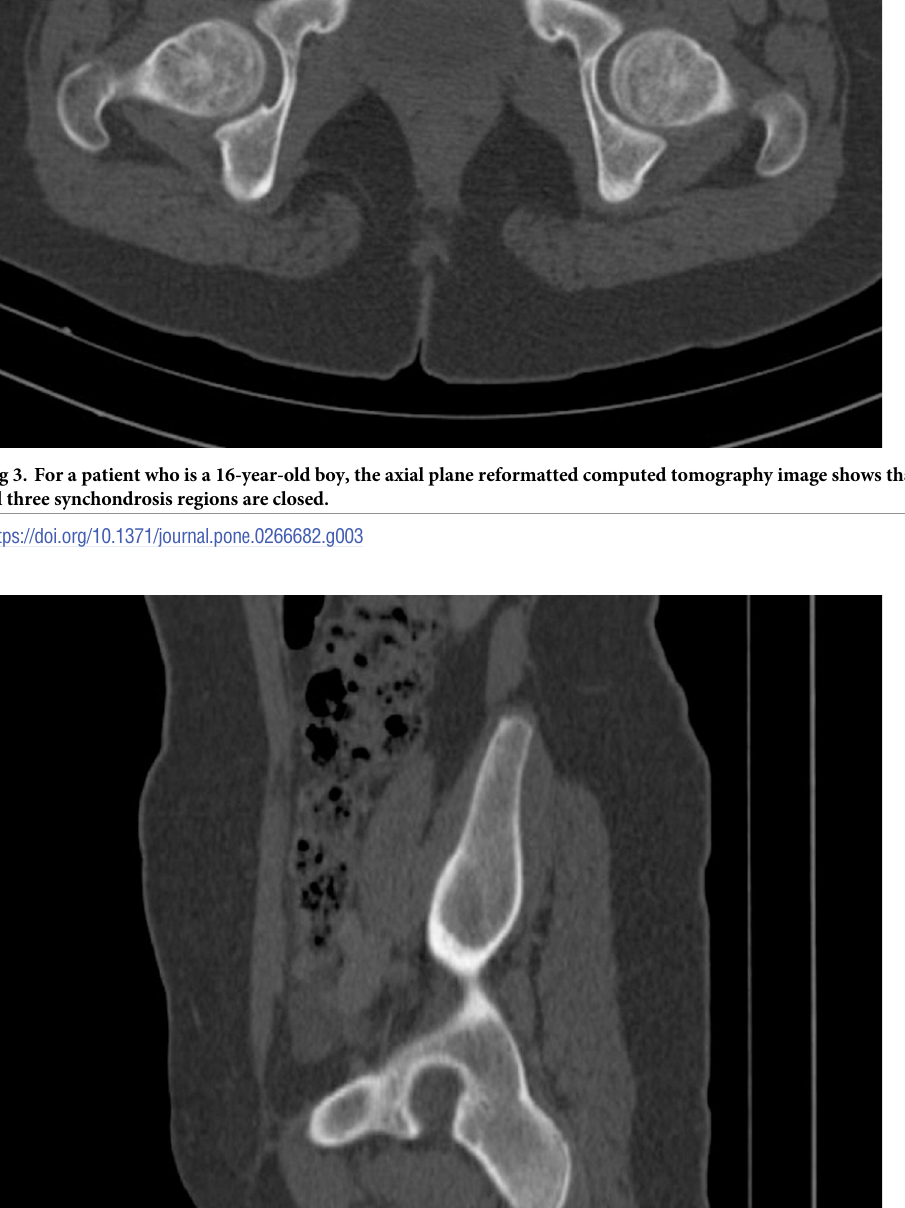
PLOS ONE | https://doi.org/10.1371/journal.pone.0266682 April 28,